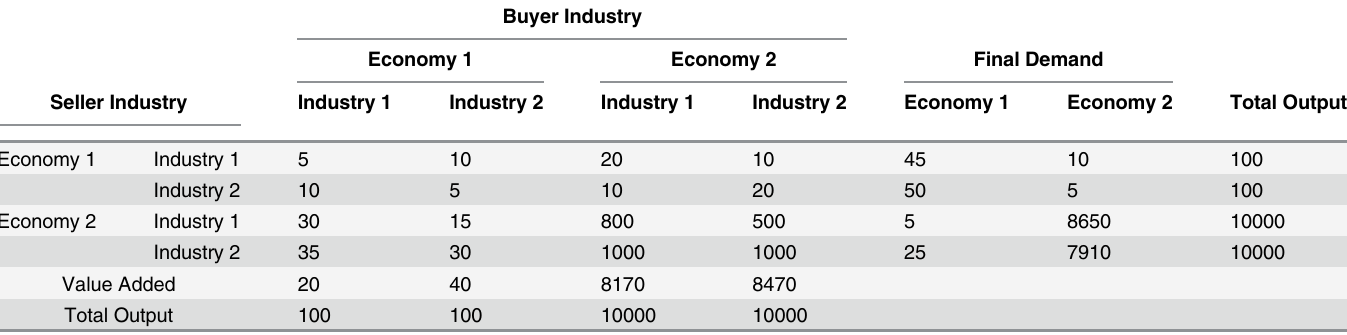
Table 1. A hypothetical two-economy-two-industry GMRIO table. The 4 × 4 inter-industry transactions matrix records outputs selling in its rows and inputs buying in its columns. The additional columns are the final demand and the additional row is the value added. Finally, the last column and the last row record the total industry outputs. The numbers are made up in such a way that Economy 2 is much larger than Economy 1 in terms of industry outputs. However, as shown below, the Rasmussen method of backward linkages will consider industries in Economy 1 more important than the ones in Economy 2. Hence, we use the Laumas method of backward linkages instead to identify the key industries in the